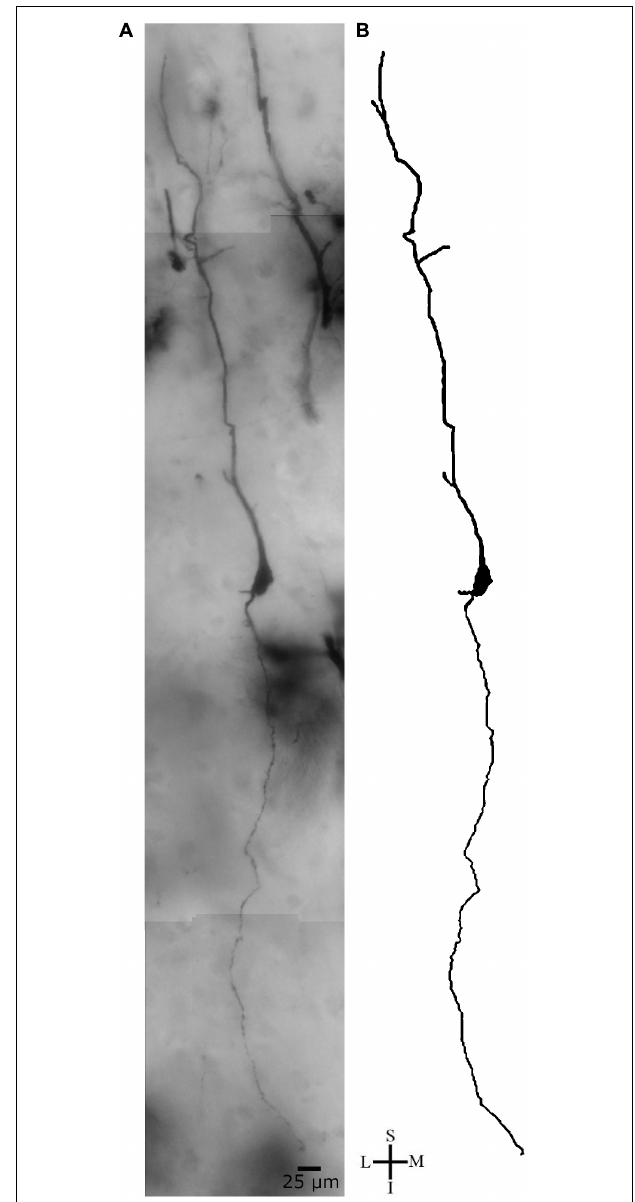
FIGURE 9 | (A) Photomicrographic composition of a Golgi-impregnated spindle-shaped neuron from layer V in the transition to layer VI in the human precuneus (central region, 61.1 mm posterior to the midpoint of the anterior commissure) observed using brightfield microscopy. (B) Two-dimensional image reconstruction of the same neuron in (A) (pial surface at the top). Note the cell body shape and the two main ascending and descending primary dendrites with rare branching points. Image reconstructed using the Neuromantic software (University of Reading, United Kingdom) with adjustment of contrast made with Photoshop CS3 (Adobe Systems, Inc., United States). Coordinates in (A,B) : I, inferior; L, lateral; M, medial; S, superior. Scale = 25 µ